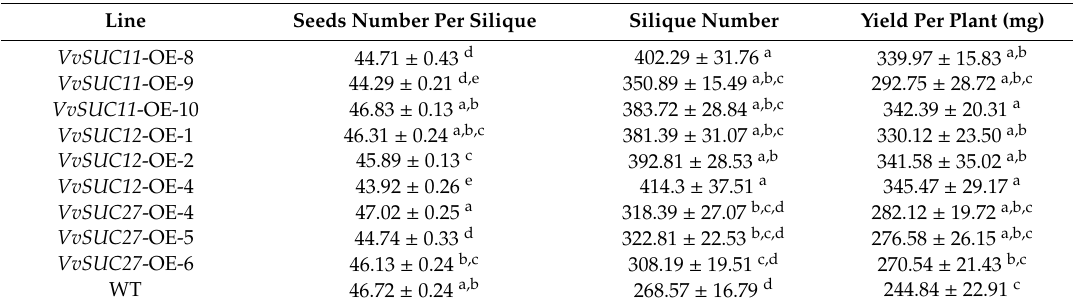
Table 1. Yield of VvSUC -OE Arabidopsis thaliana